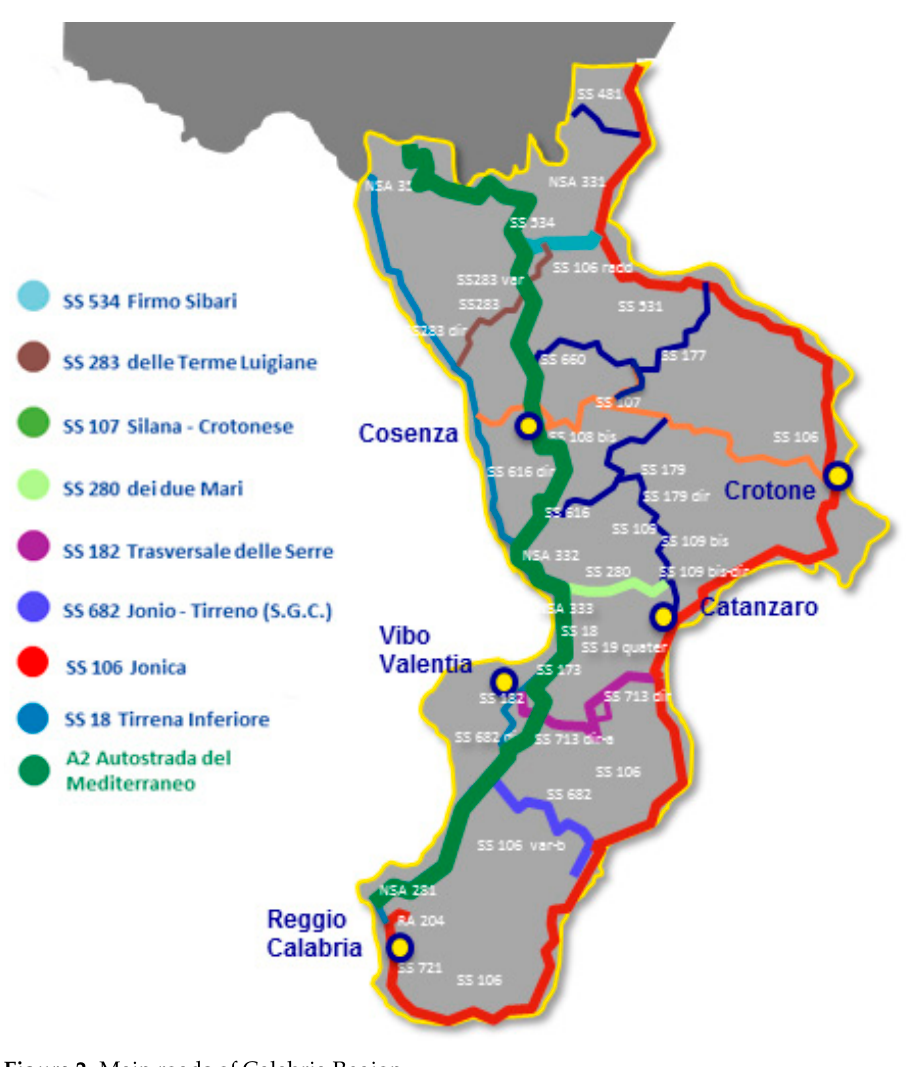
Figure 2. Main roads of Calabria